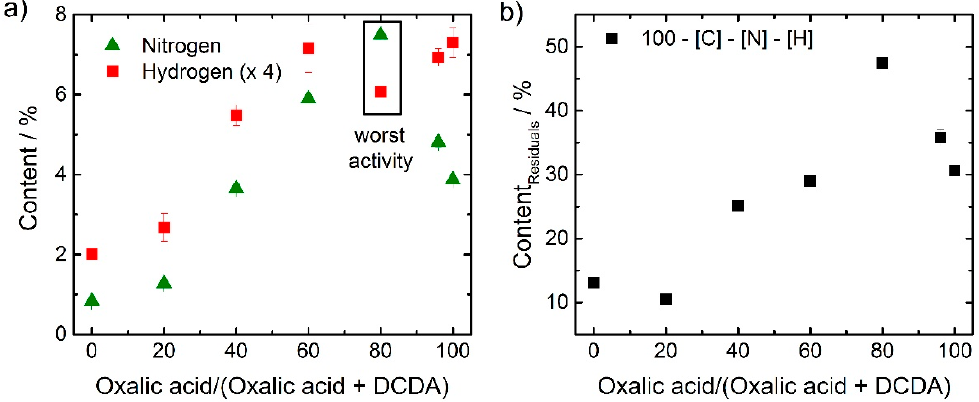
Figure 5. Results of elemental analysis for nitrogen ( ▲ ) and hydrogen ( ■ ) (values multiplied by factor of four) are shown ( a ). In ( b ) the content assigned to residuals is given ( ■ ).